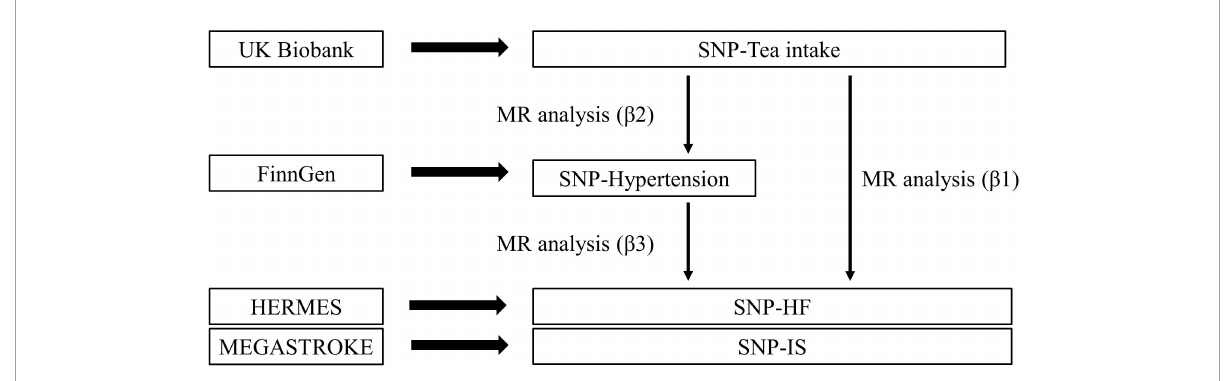
FIGURE2 Overview of the two-step method Mendelian randomization. Total effect= β 1; Mediation effect= β 2 ∗ β 3; Direct effect= β 1– β 2 ∗ β 3; Proportion mediated= ( β 2 ∗ β 3)/ β